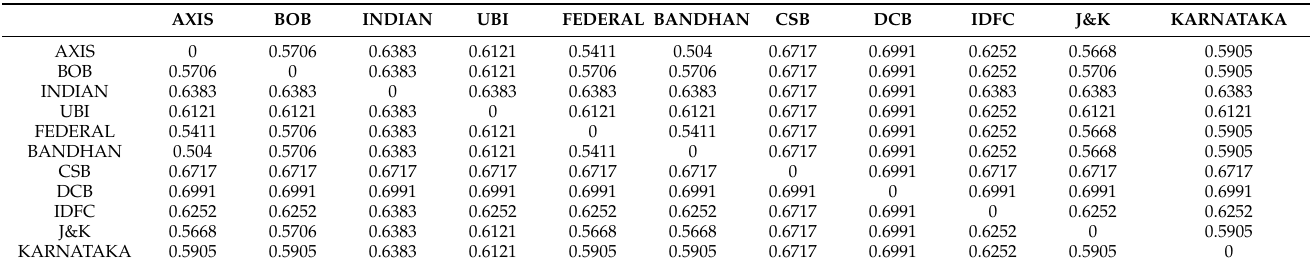
Table 11. Adjacency matrix of the strength of connectedness (last component): reduced list of 11